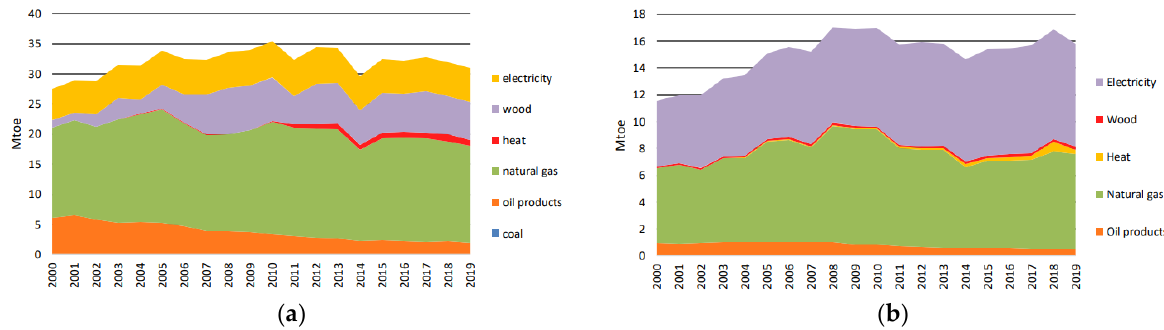
Figure 3. Final energy consumption (Mtoe) in the residential ( a ) and nonresidential ( b ) sectors, from 1990 to 2019 [26].